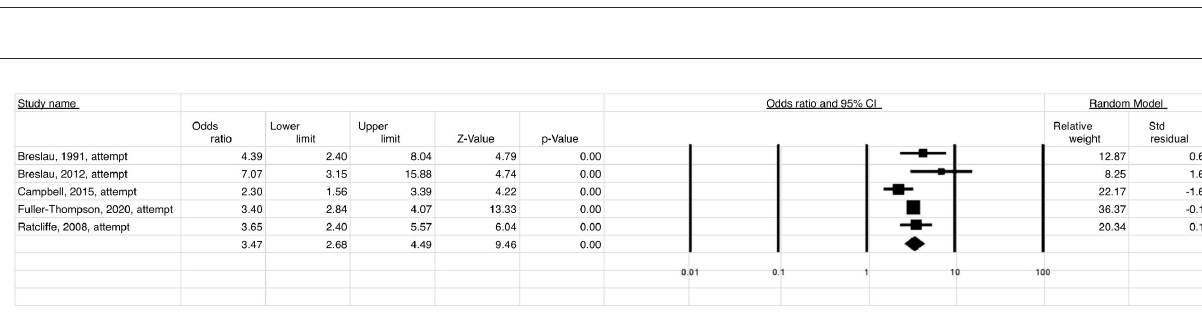
FIGURE5 Relationship between suicide attempt (OR = 3.47) in patients with migraine when compared to healthy